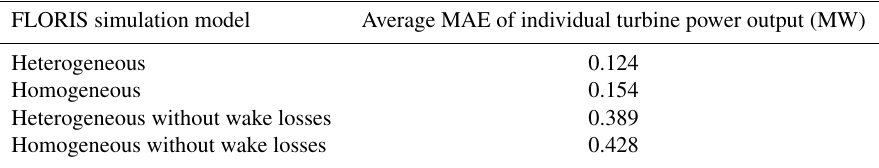
Table B2. Mean absolute error of individual turbine power outputs for four different FLORIS models compared to LES simulations, as discussed in Sect. 4.1. An average MAE is reported, which was taken over all wind direction cases.